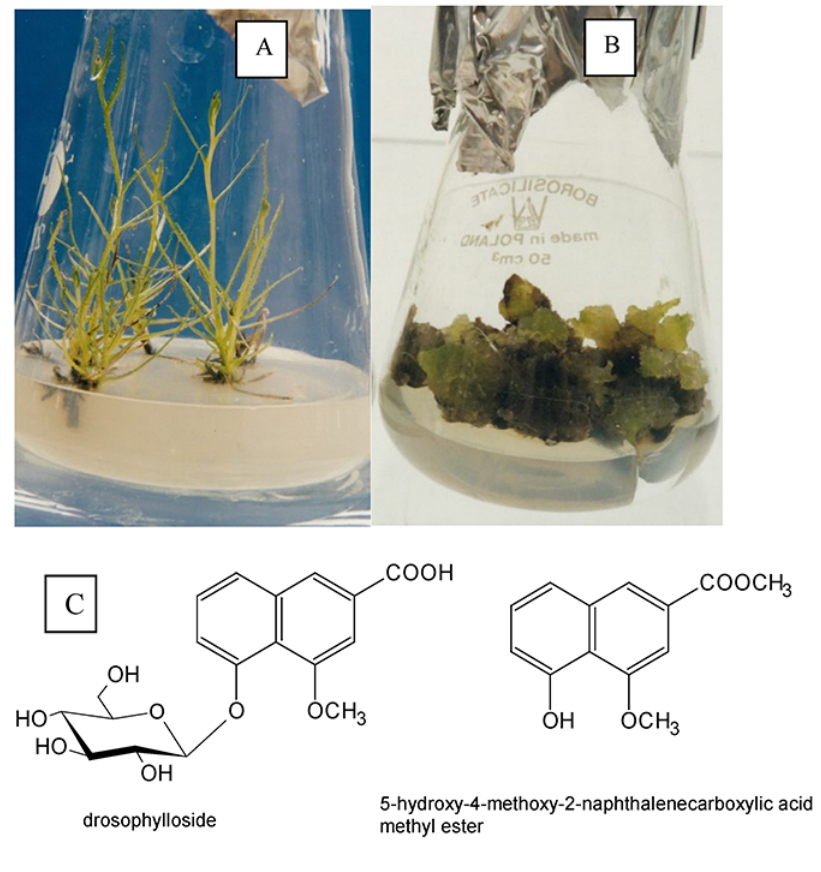
Figure 8 Drosophyllum lusitanicum ( A ) shoot and ( B ) callus cultures. ( C ) New naphthalene derivatives.